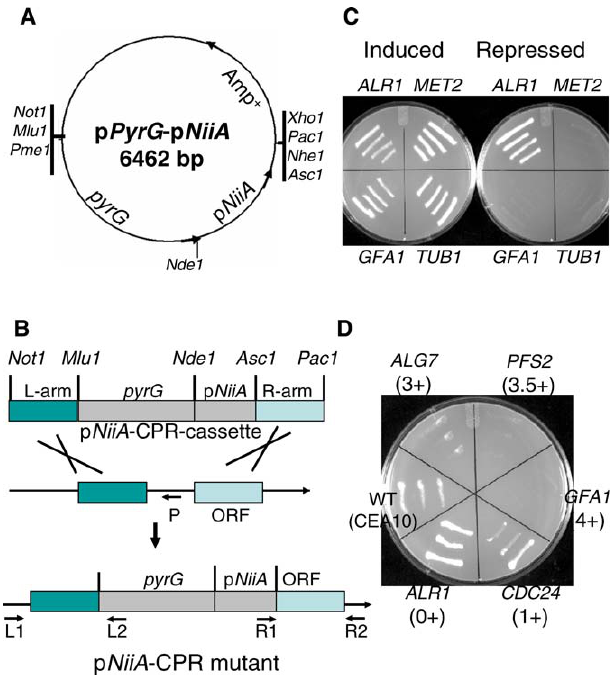
Figure 1. Outline of the A. fumigatus p NiiA -CPR